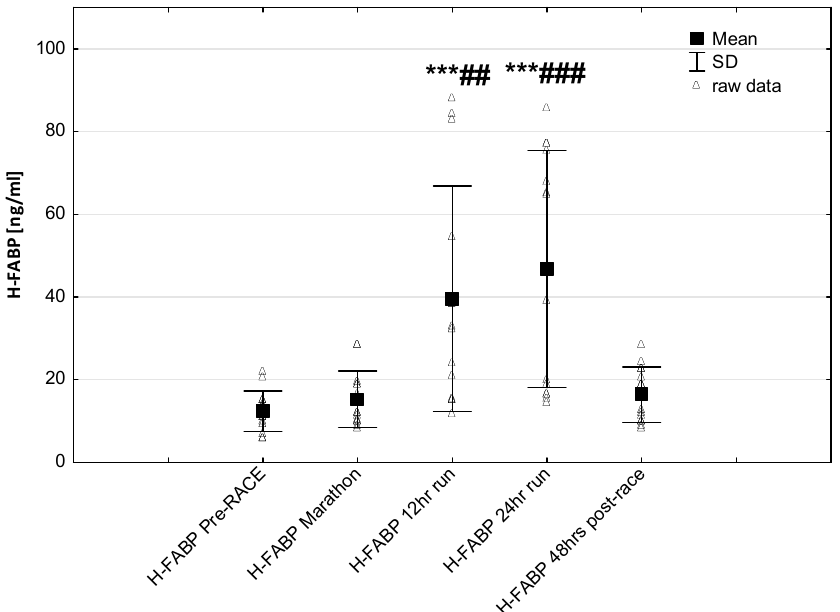
Figure 6. Ultra-marathon-induced changes in serum heart-type fatty acid binding protein (H-FABP). *** p < 0.001 versus the corresponding pre-race value (Pre-race); ## p < 0.01, ### p < 0.001 versus the corresponding post-marathon value (24-h run).